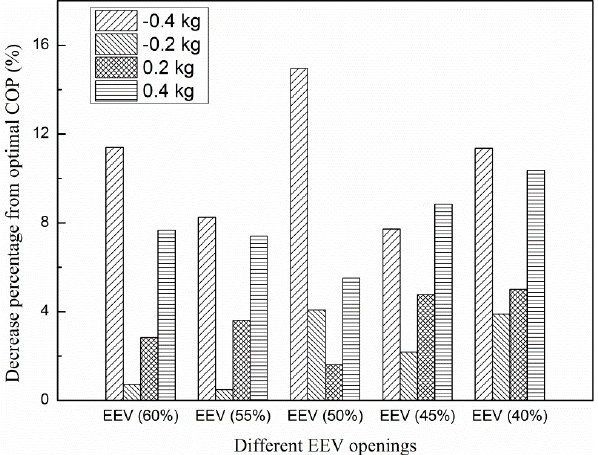
Figure 11. Decrease percentage from optimal COP as refrigerant charge deviated from corresponding optimal charge.